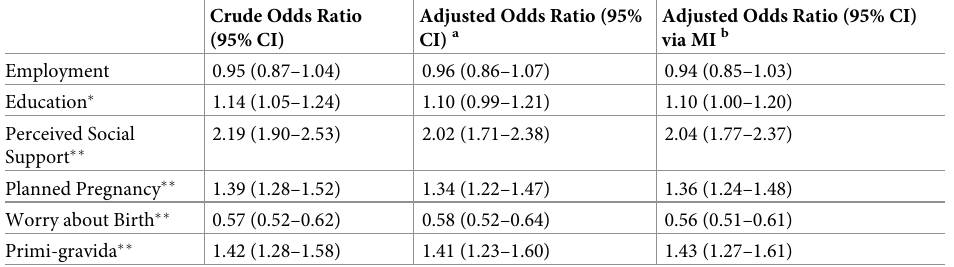
Table 2. Crude and adjusted associations between sociodemographic and pregnancy-related factors and self- reported levels of happiness in pregnant women in Al Ain, UAE. The Mutaba’ah